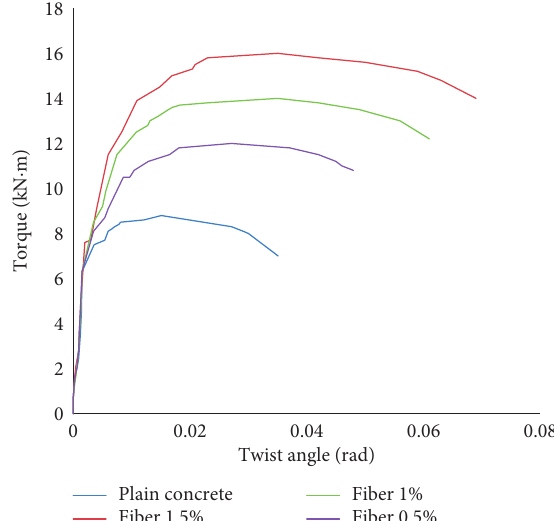
Figure 8: Torque-twist angle relationship of mixing steel fibers.